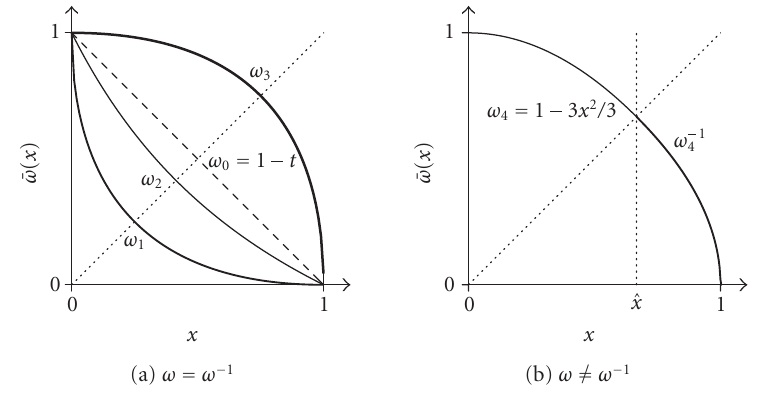
Figure 3.2. Diagonal-symmetricity of ω in